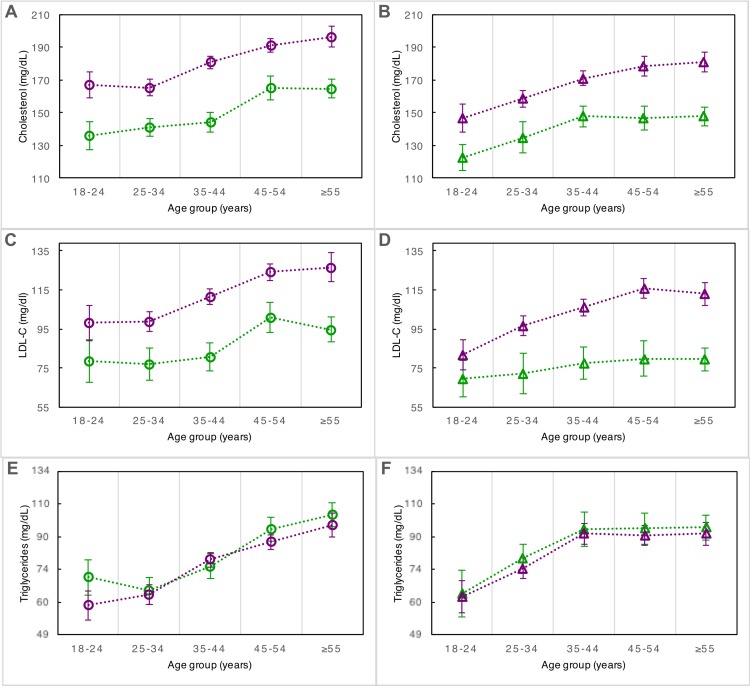
Mean lipid levels by age group in urban and rural men and women from Brong Ahafo, Ghana.In the left panels (A), (C), and (E), mean estimates by age group are depicted for urban females (purple circles) and rural females (green circles). In the right panels (B), (D), and (F), mean estimates by age group are depicted for urban males (purple triangles) and rural males (green triangles). Error bars denote 95% confidence intervals. Note: in (E) and (F), vertical axis is logarithmic.